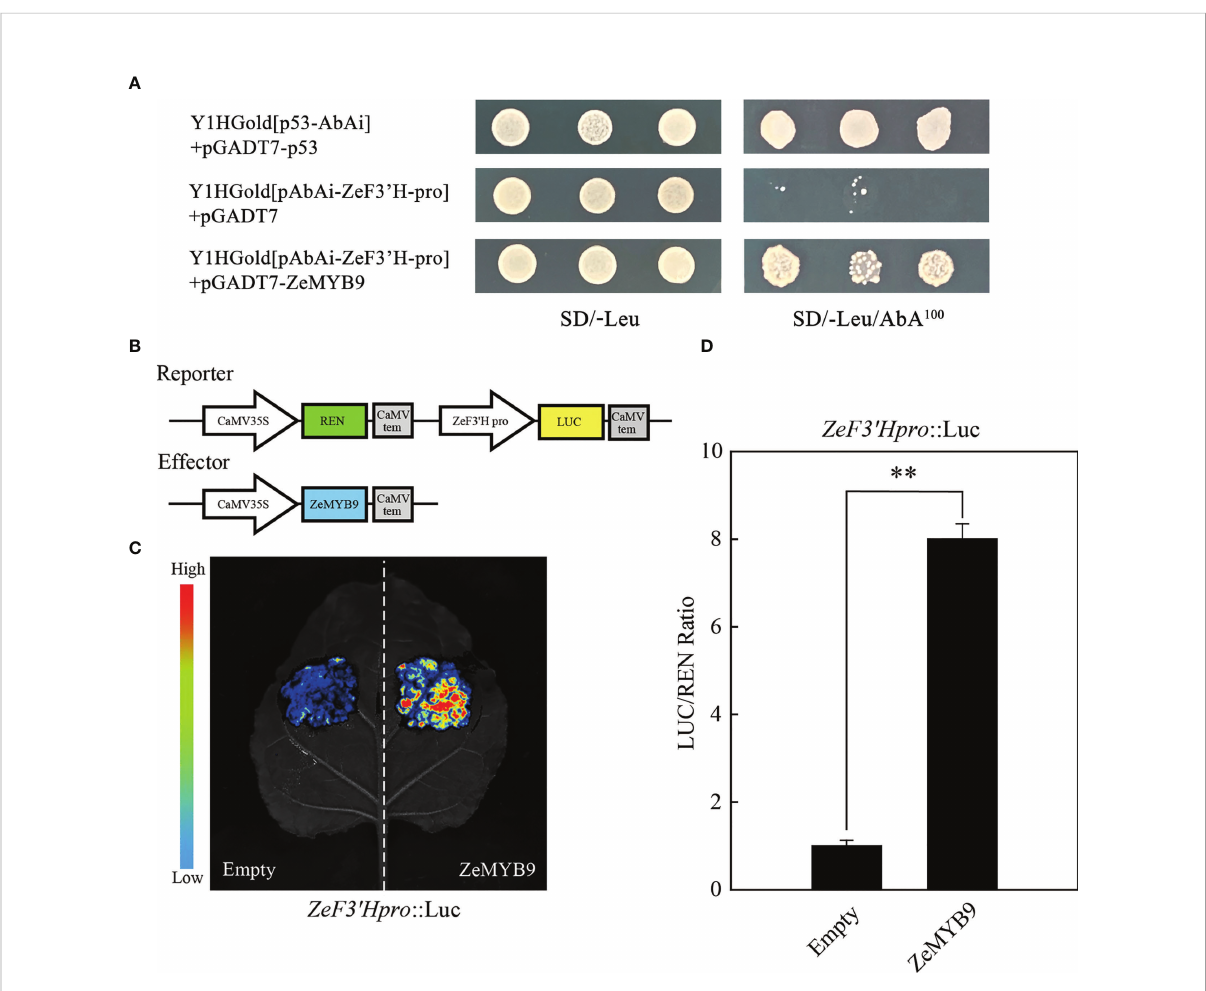
FIGURE 3 ZeMYB9 could directly bind to the promoter of ZeF3 ’ H . (A) Yeast one-hybrid assay showing the binding of ZeMYB9 to the promoter of ZeF3 ’ H . (B) Construction diagrams of reporter and effector vectors for dual-luciferase assays. (C) Graph showing the luminescence intensity of luciferase in N. benthamiana leaves. (D) Transient dual-luciferase detections of ZeF3 ’ H in N. benthamiana leaves. Data were showed as the mean ± SE from three biological replicates. T-test was used for statistical analyses compared with corresponding control (** P <